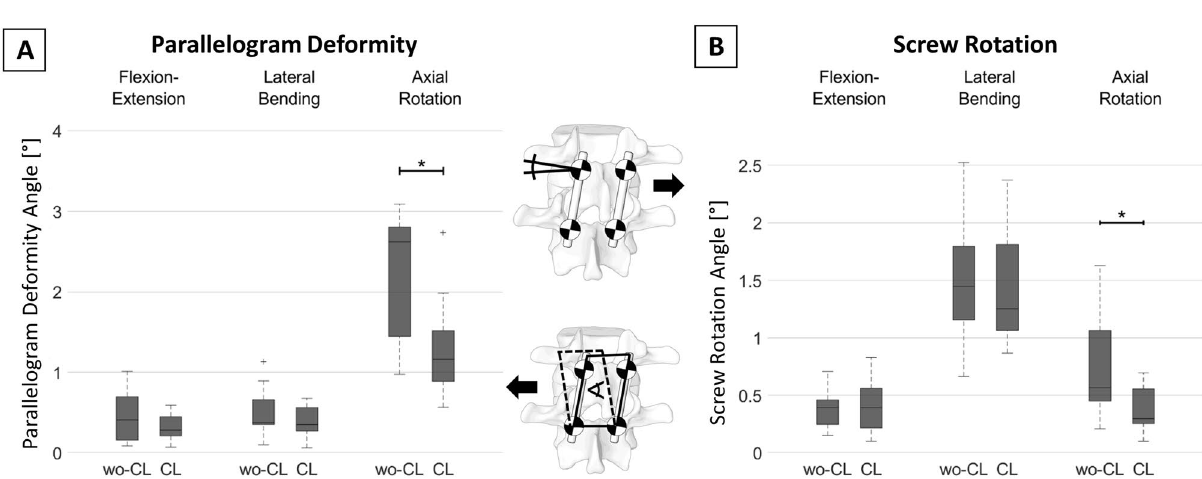
Figure 4. Effect on ( A ) parallelogram deformation and ( B ) screw rotation by the addition of a crosslink to the construct. Significant differences (p < 0.05) are marked with an asterisk (*), wo-CL configuration without crosslink, CL configuration with